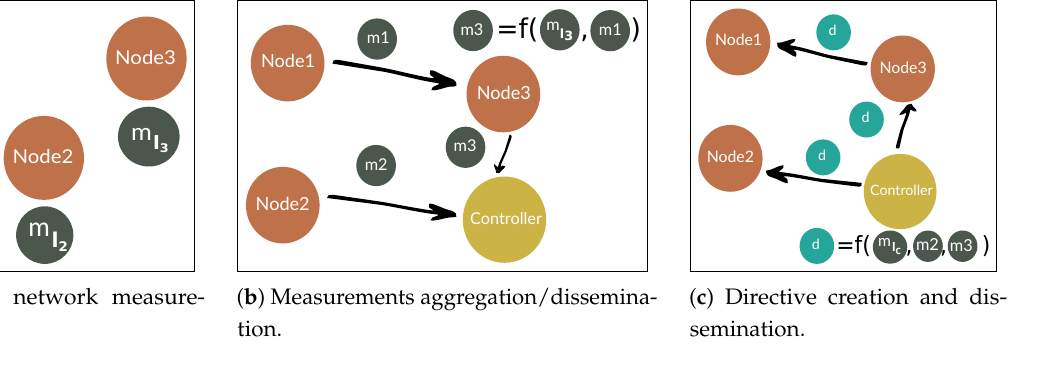
Figure 1. Node’s GAFA functionality: ( a ) gathering measurements, ( b ) aggregating and forwarding them, ( c ) applying the directive created by the